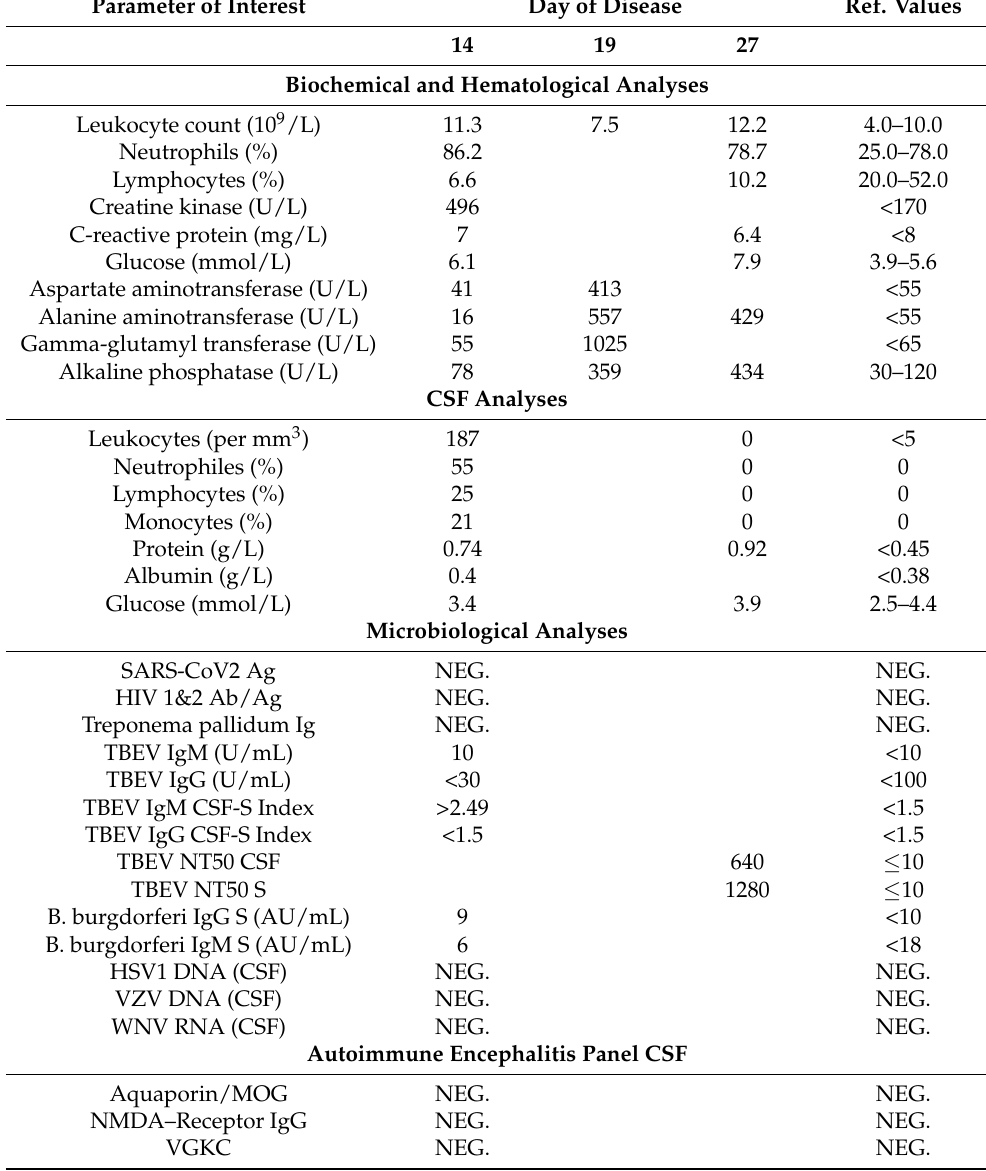
Table 1. Laboratory findings in patient with